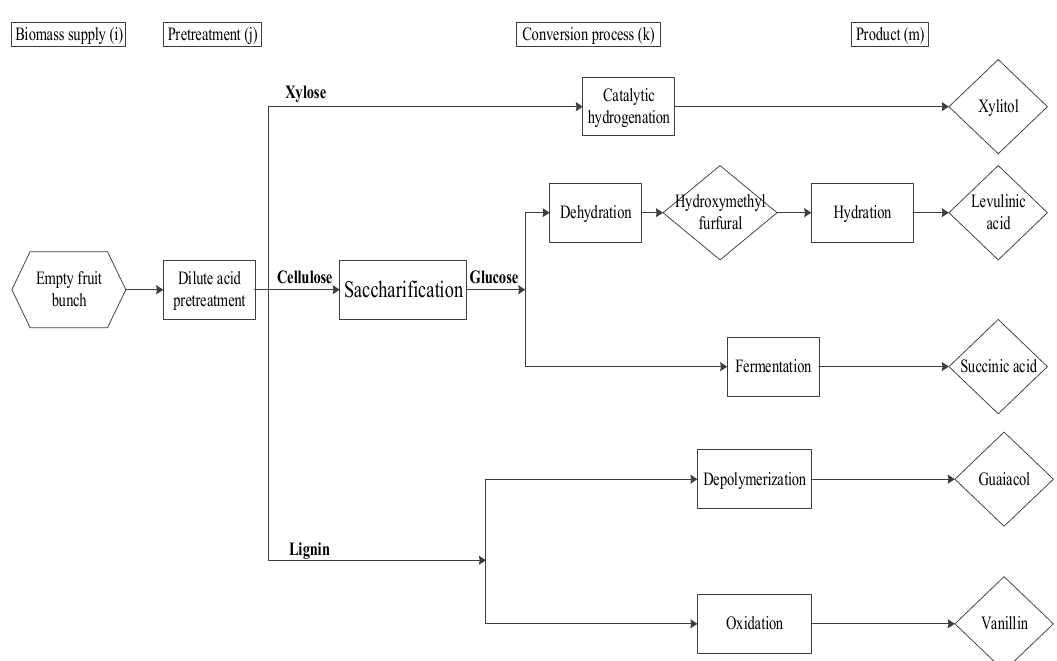
Figure 3. Schematic of the integrated biorefinery from the empty fruit bunch (EFB).